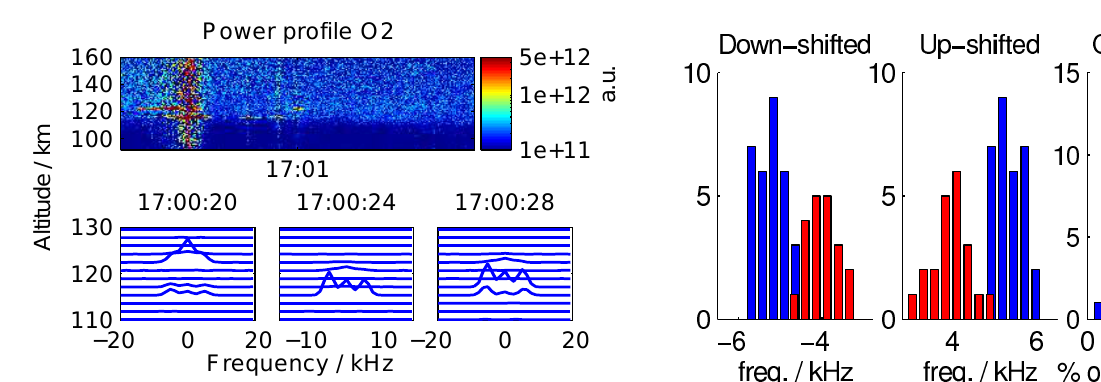
Fig. 5. Statistical properties of the ion-line spectrum recorded dur- ing the second heating cycle (17:00–17:02UT) split into top and bottom layer shown in red and blue respectively. Left and centre panel: frequency distribution of the ion lines. The left panel shows the down-shifted ion line; the centre panel the distribution for the up-shifted one. Right panel: distribution of the central feature am- plitude relative to the amplitude of the enhanced ion